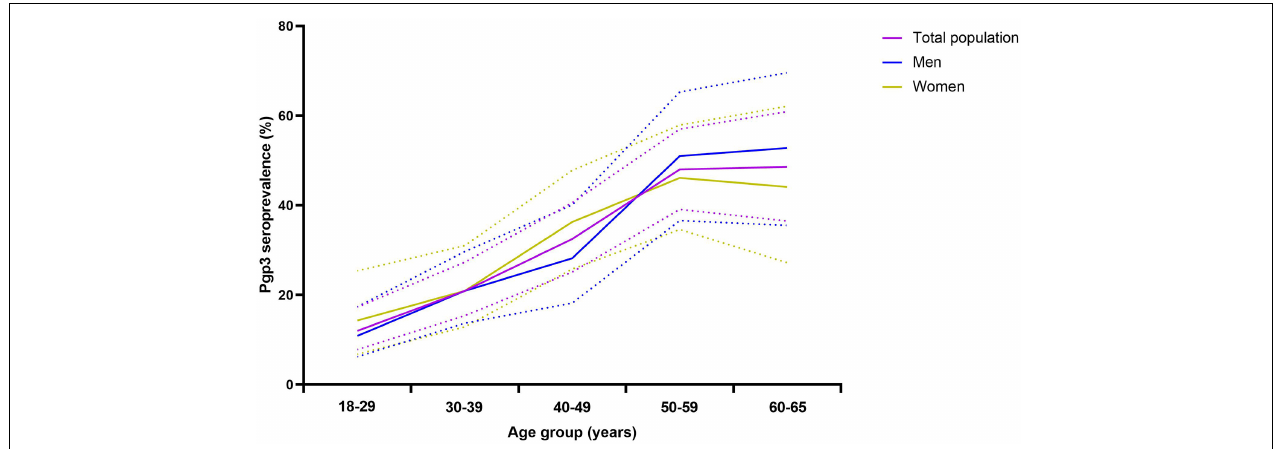
FIGURE 3 | Frequency of anti-Pgp3 antibody by age groups in total population (purple), men (blue) or women (brown), China, 2014. Anti-Pgp3 antibody was tested in 744 participants including 405 men and 339 women in 2014. Seropositive frequency of C. trachomatis infection was represented by anti-Pgp3 IgG antibody positive rate. Solid lines indicate the frequency for whole population (purple), men (blue) or women (brown), respectively. Dash lines indicate the 95% “exact” Clopper–Pearson confidence interval of the seropositive frequency.